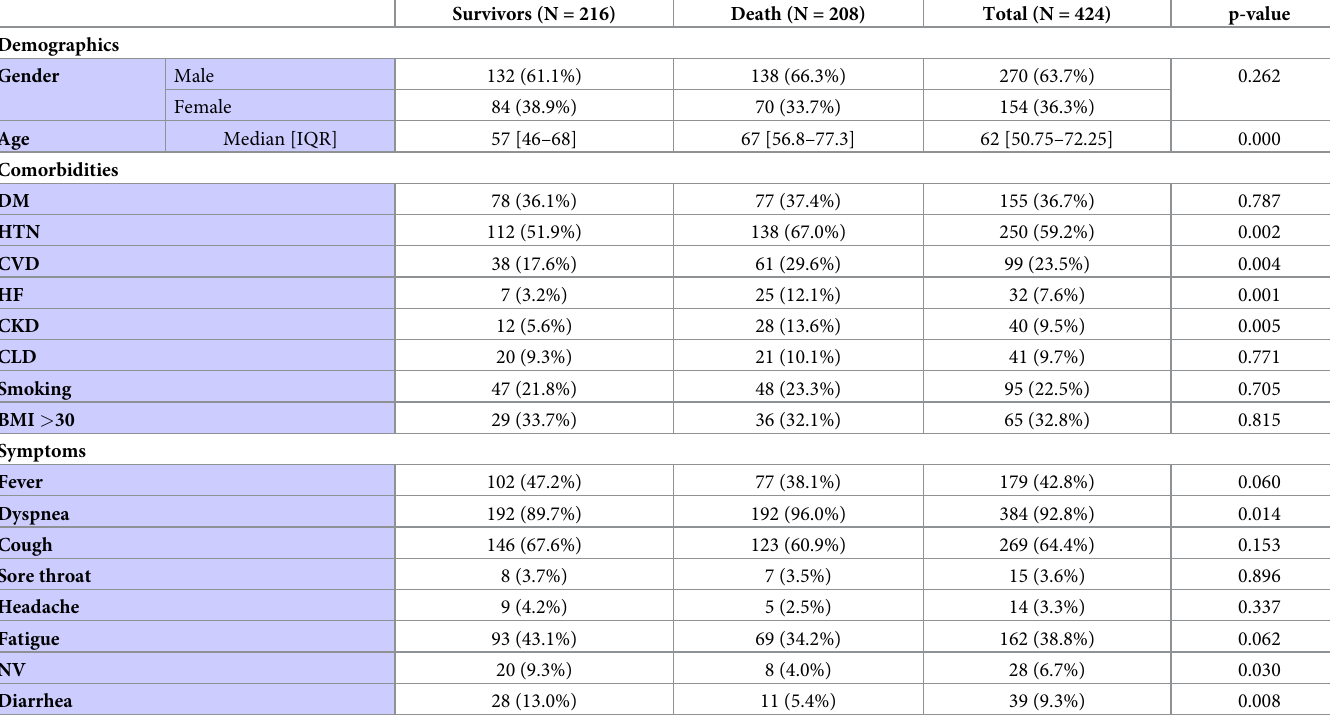
Table 2. Demographics, medical comorbidities and